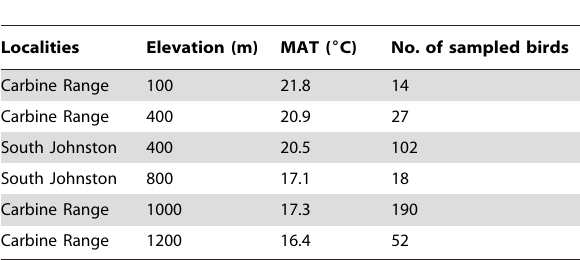
The elevation, Mean Annual Temperature (MAT) and Number of sample birds for each locality are